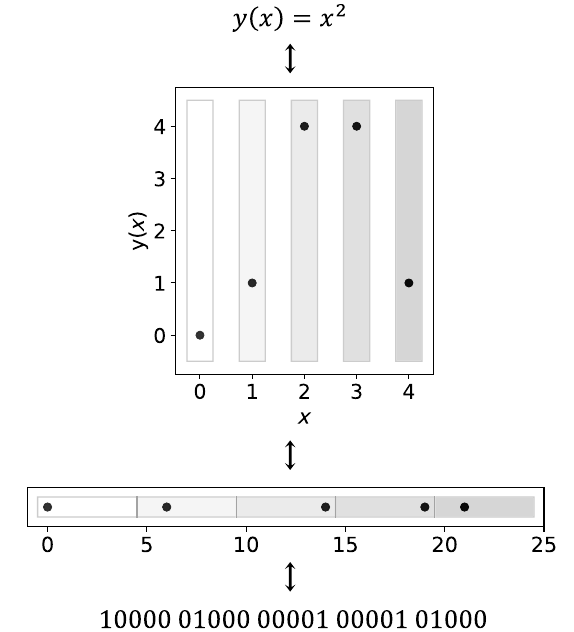
FIG. 2. The mapping from a function over Z L (cid:12) to an elemen- tary codeword may be viewed as a linearization of the graph of the function, as illustrated in this figure for the function y ( x ) = x 2 over Z 5 . To obtain the linearization, the columns of the graph of y ( x ) are laid out in order horizontally: the locations of the points in the linearization give the locations of the 1s in the correspond- ing codeword. The shading of the columns in the graph matches their shading in its